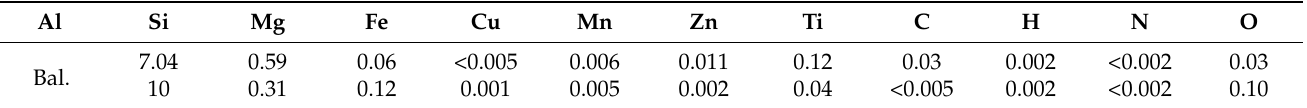
Table 1. Nominal chemical composition (wt.%) of AlSi7Mg0.6 and AlSi10Mg0.3 gas-atomized powders.